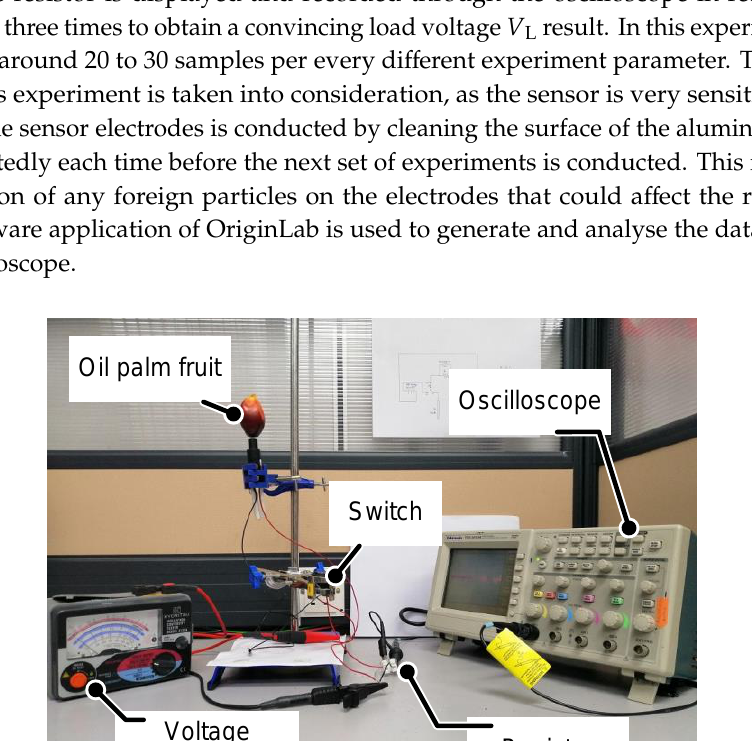
Figure 5. Drying process for moisture content. 3.4. Data Evaluation The data is comprised of the load voltage V L and moisture content w of all the samples tested. Figure 6 shows the evaluation of the raw data of the sample obtained from the oscilloscope reading. OriginLab software (OriginPro 2015, OriginLab Corporation, Northampton, MA, USA) is used to identify and generate simple mathematical expressions for data extraction. Figure 6a shows the raw data of one condition of a sample after the noise has been filtered. Since the raw data of the fruit